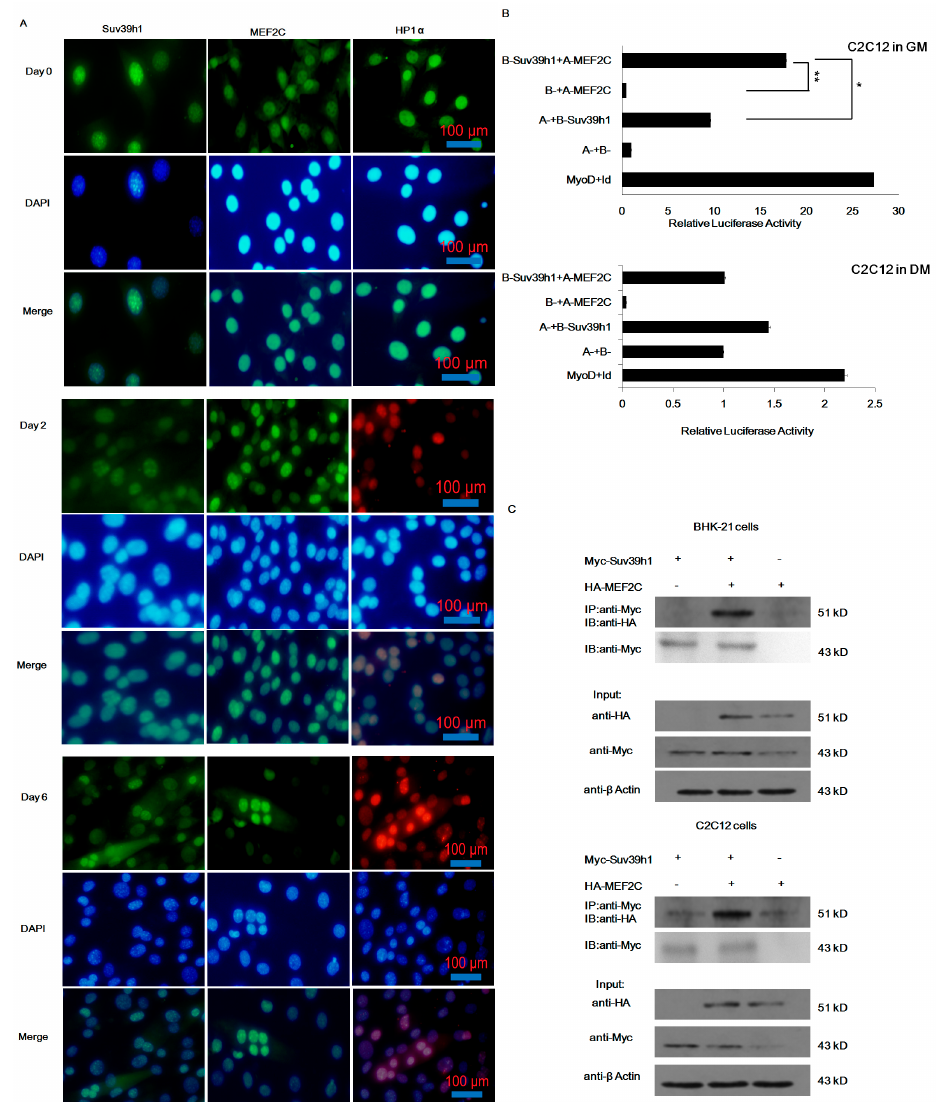
Figure 5. Suv39h1 and MEF2C interacted in vitro and in vivo. ( A ) Locating of Suv39h1, HP1 α , and MEF2C in C2C12 cells during differentiation. The red TRITC (rhodamine) and green FITC (fluorescein isothiocyanate) antibodies were against anti-Suv39h1, anti-HP1, and anti-MEF2C antibodies as indicated, respectively. Red TRITC- or green FITC-stained cells represented the indicated proteins at indicated time; ( B ) Plasmids, including reporter plasmid pG 5luc were co-transfected into C2C12 cells. Then, cells were separately maintained in growth medium (GM) or differentiation medium (DM). The luciferase activity was measured 48 h after transfection. Firefly luciferase levels were normalized against Renilla luciferase levels. Bars represent the mean ± SD of three experiments. The statistical significance of the differences values was analyzed by Student’s t -test, * p < 0.05, ** p < 0.01; ( C ) BHK-21 and C2C12 cells were co-transfected with Myc-tagged Suv39h1 and/or HA-tagged MEF2C as indicated; Top: Suv39h1 proteins were immunoprecipitated with anti-Myc antibodies, and anti-HA antibodies were used to detect the presence of MEF2C proteins in the immunoprecipitates by Western blot analysis. Anti-Myc antibodies was used as control to detect the presence of Suv39h1 proteins; Bottom: Ten percent of cell extracts were immunoblotted to detect the presence of Suv39h1 and MEF2C proteins.